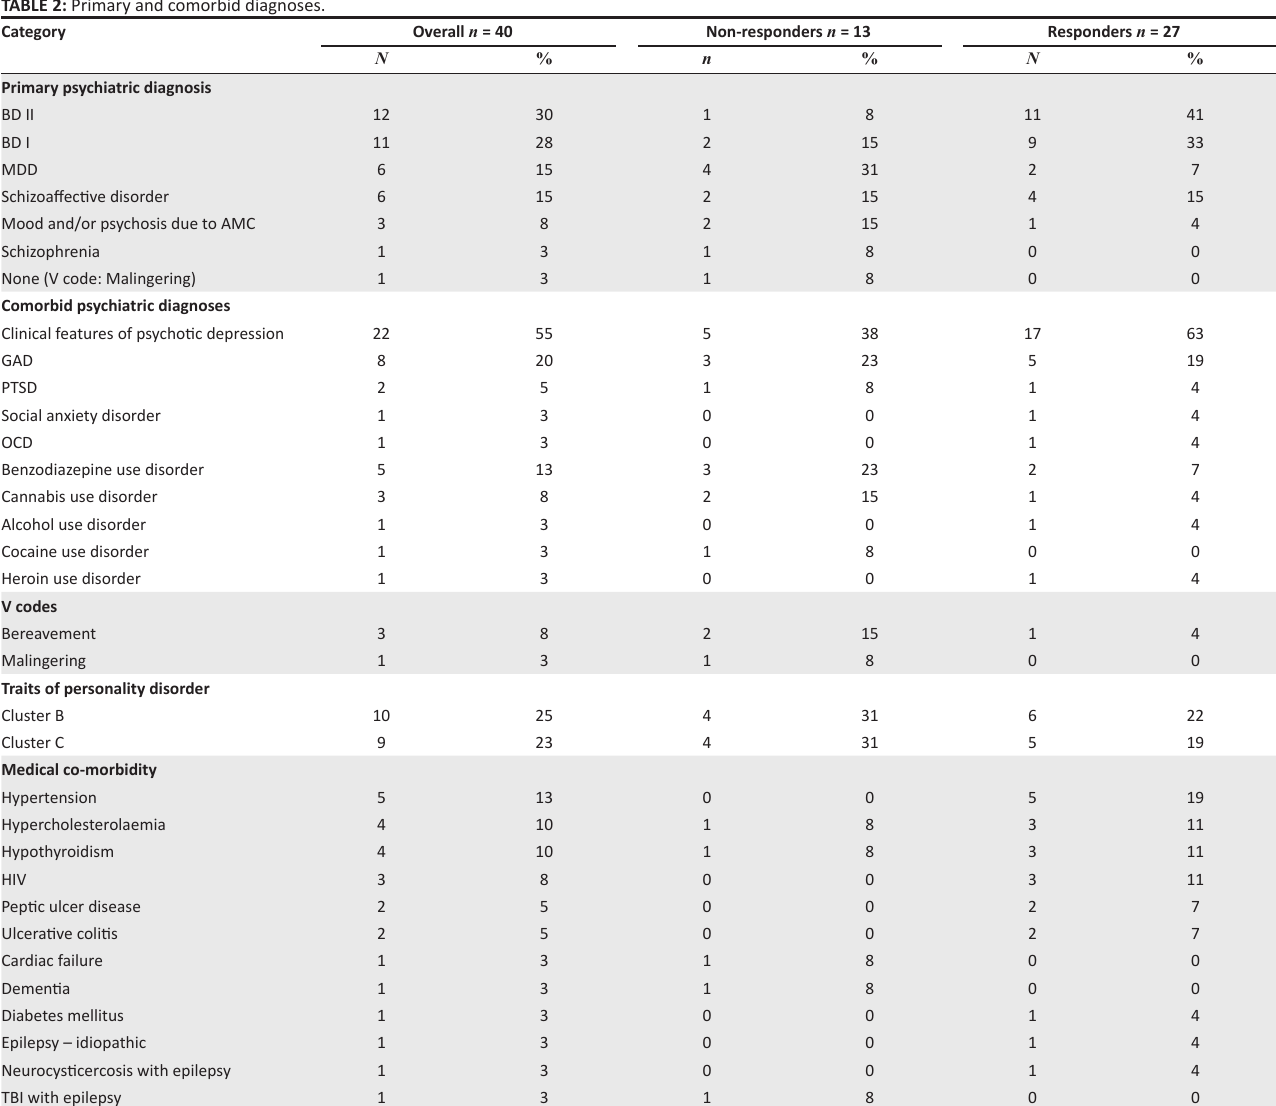
TABLE 2: Primary and comorbid diagnoses.